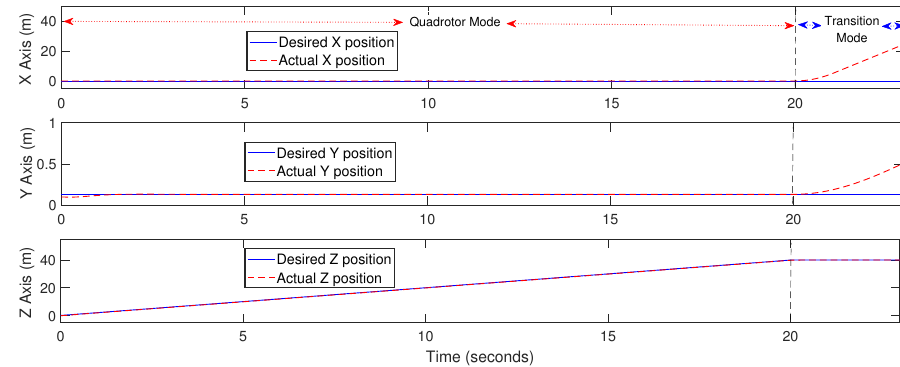
Figure 5. Position tracking during quadrotor mode and transition